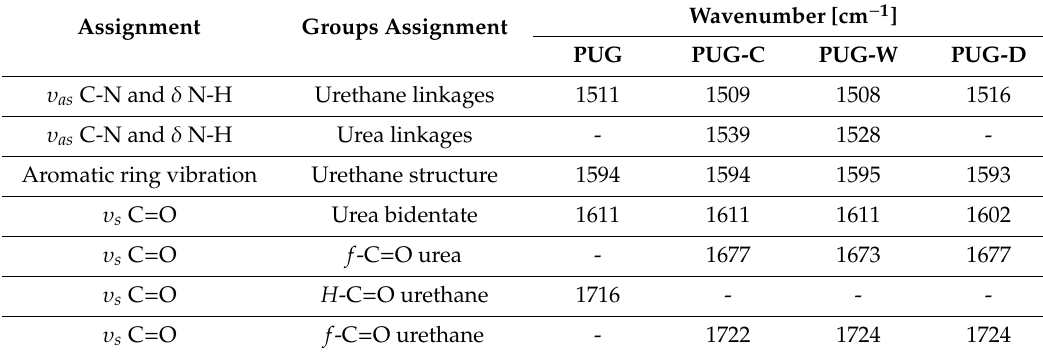
Table 3. Assignments of the main FT-IR bands of produced